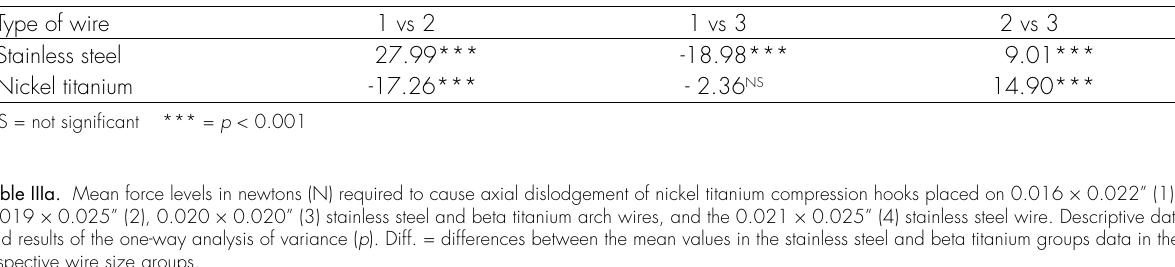
Table IIb. Differences and significance levels obtained from the post-hoc pairwise comparisons of the mean values and standard deviations presented in Table IIa.